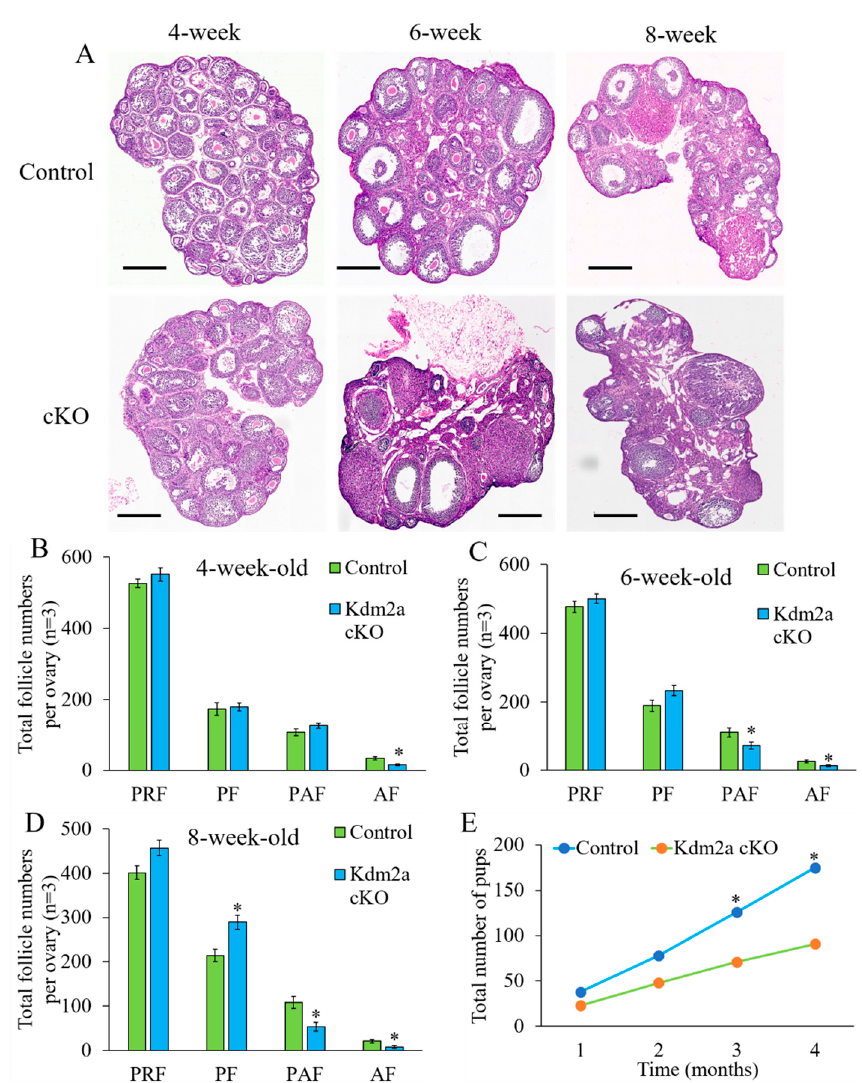
Figure 4. Kdm2a cKO ovaries display some defects in follicle development. ( A ) HE staining of 5 μ m cross sections of Kdm2a cKO ovary and control ( Kdm2a flox/flox ) ovary. Scale bar, 25 mm. ( B – D ) Propor- tion of primordial follicle (PRF), primary follicle (PF), preantral follicle (PAF), and antral follicle (AF). The difference between the control and Kdm2a cKO was observed according to two-way ANOVA test. ( E ) The total number of pups produced from control and Kdm2a cKO group (n = 6) in four months. * Significant difference ( p < 0.05). Scale bars, 50 μ m.